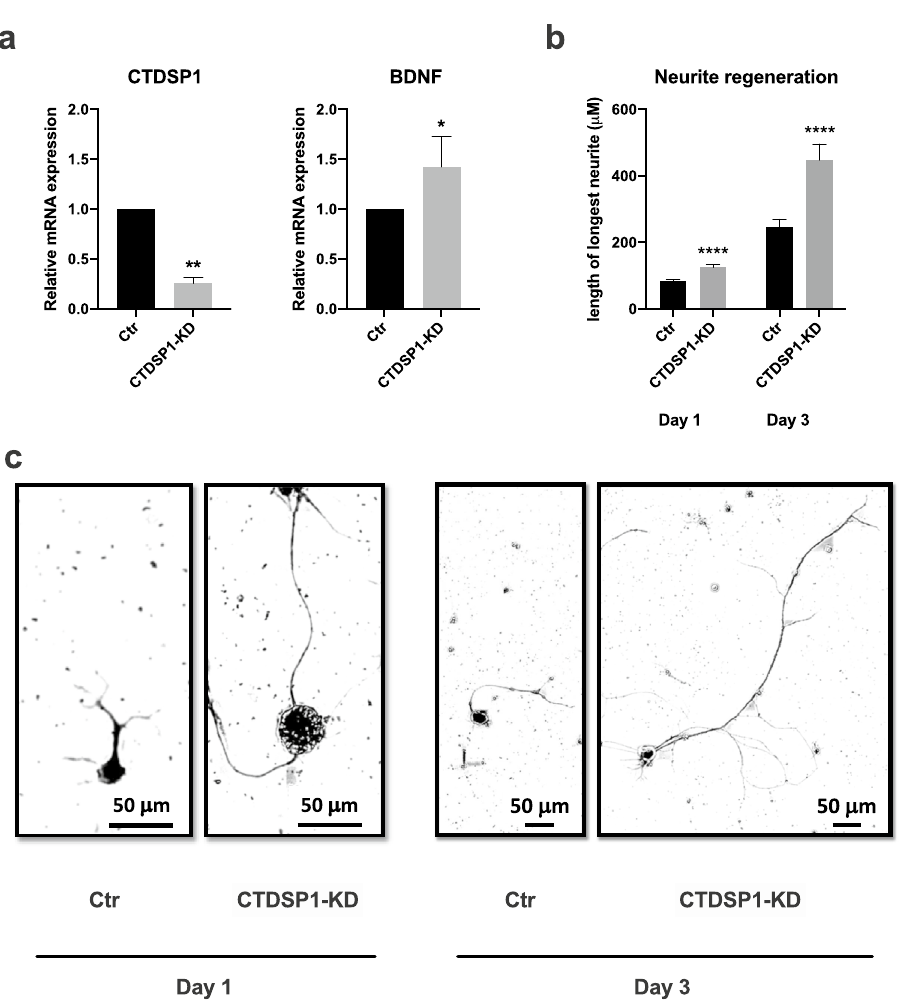
Figure 5. Knockdown of CTDSP1 in DRG neurons promotes BDNF expression and neurite regeneration. ( a ) qRT-PCR analysis of mRNA expression levels in cultured DRG neurons 24 h after CTDSP1 siRNA transfection. * p < 0.05, ** p < 0.01, paired two-tailed Student’s t -test with n = 4 biological replicates, error bars are SD. ( b ) Quantification of the length of the longest neurite of dissociated DRG neurons in culture 1 day and 3 days after REST or CTDSP1 knockdown. **** p < 0.0001, Mann–Whitney test, n = min 68 neurites from 3 biological replicates, error bars are SEM. ( c ) Representative images of neurons after CTDSP1 knockdown. Ctr = scramble siRNA control, KD: